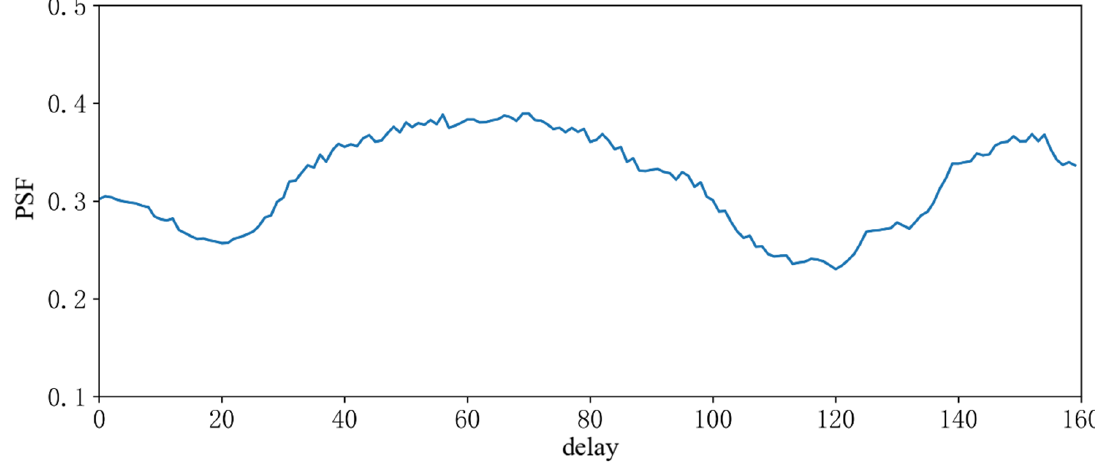
Figure 10. Effect of time delay on PSF in three neurons model 1(b-3).